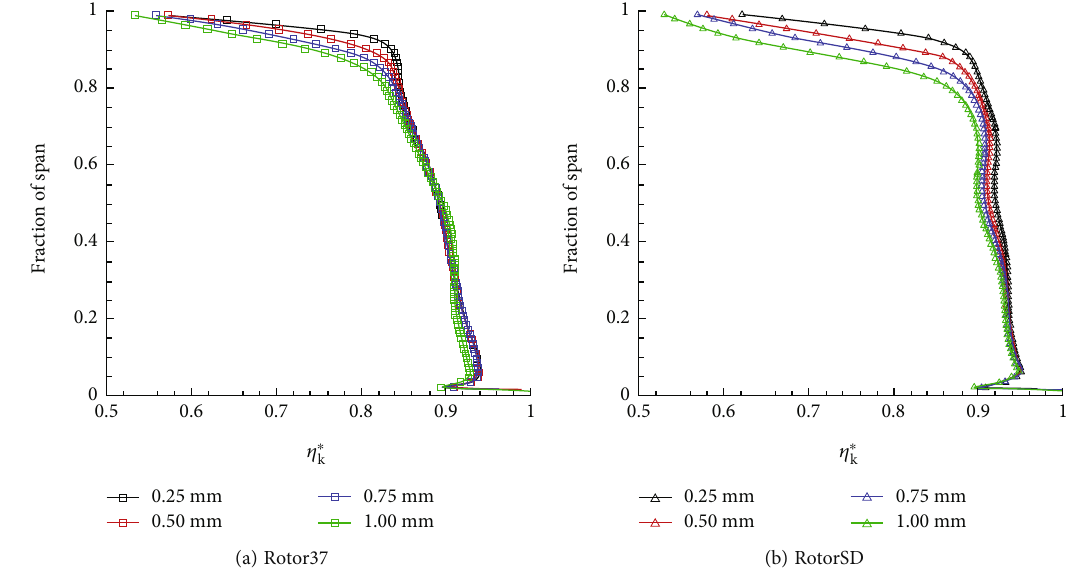
Figure 10: Isentropic e ffi ciency distribution along the